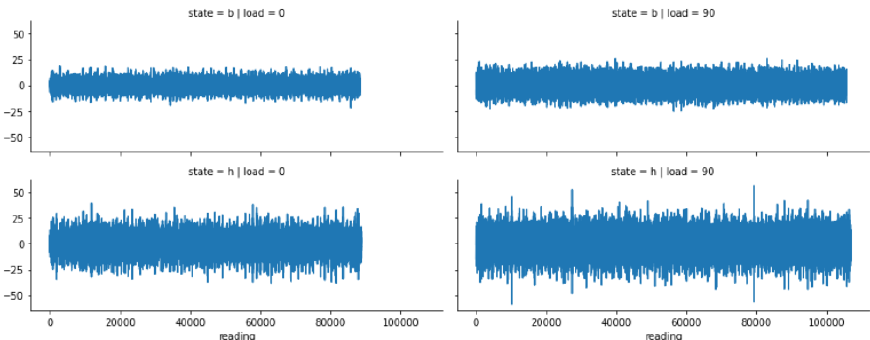
Figure 4. Time-domain analysis of different scenarios for load 0 and